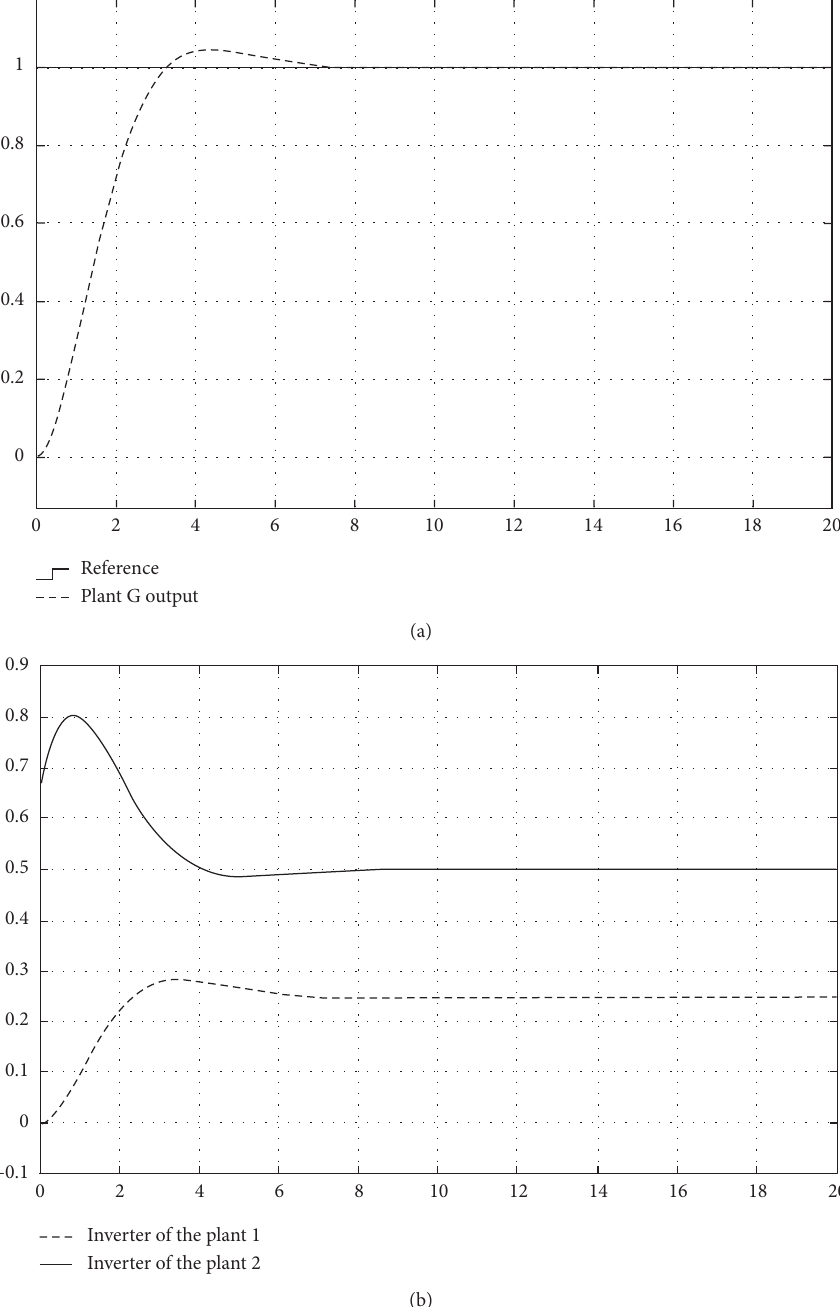
Figure 6: (a) Plant outputs and reference for plant1 and plant2. (b) Controller outputs for plant1 and